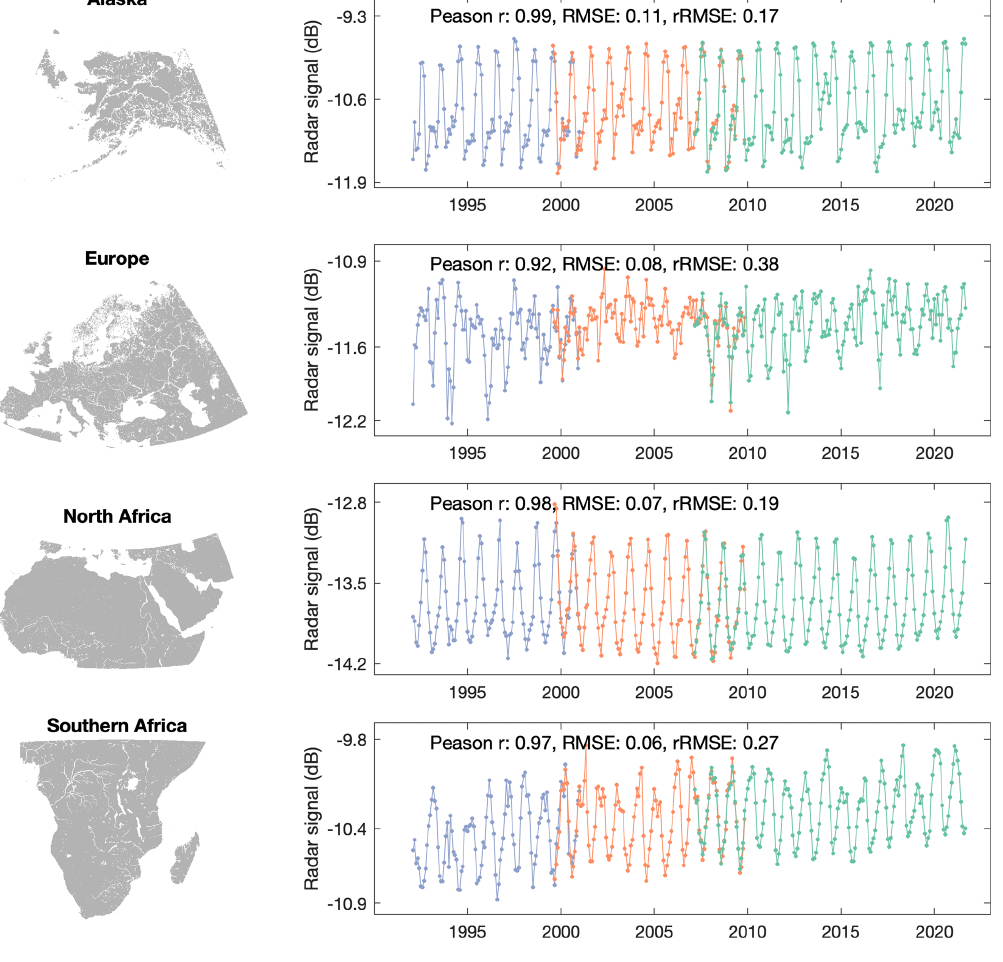
ilar monthly dynamics between the merged radar signals